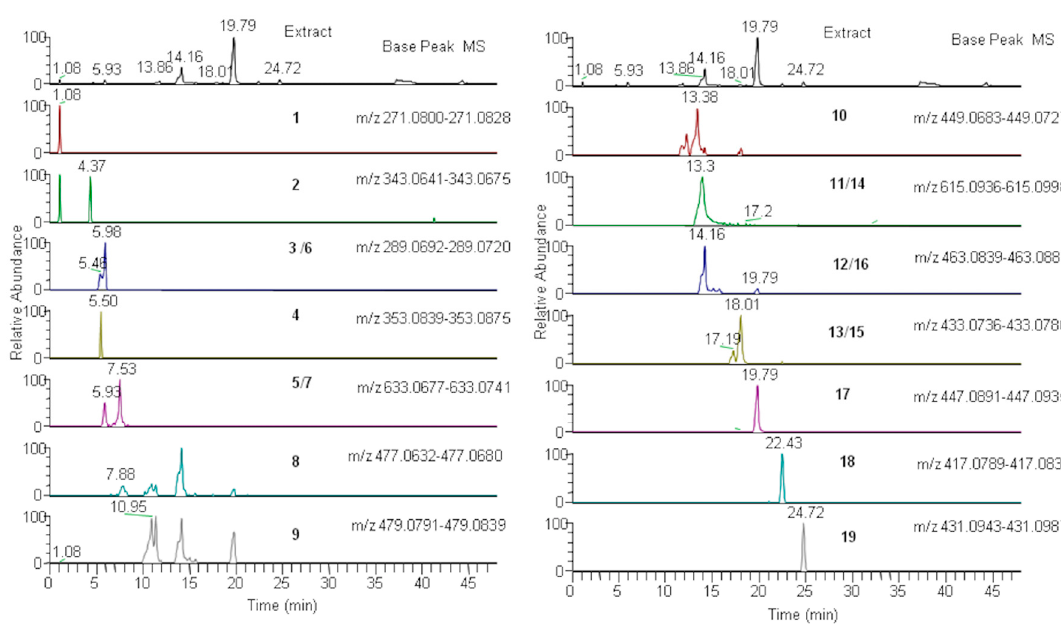
Figure 3. LC–ESI–MS / MS (Liquid Cromatography Elettrospray Ionization Mass (Mass) Spectrometry) profile and reconstructed ion chromatograms of Arbutus leaves extract. Number corresponds to the identified metabolites reported in Table 1.